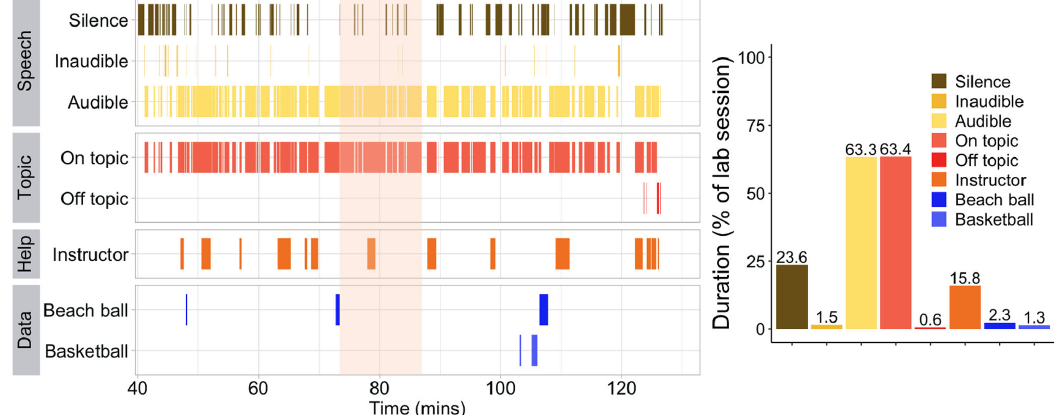
FIG. 12. Group C full timeline highlighting episode analyzed in Ref. [20] and durations of each behavior as a percentage of the video analyzed.